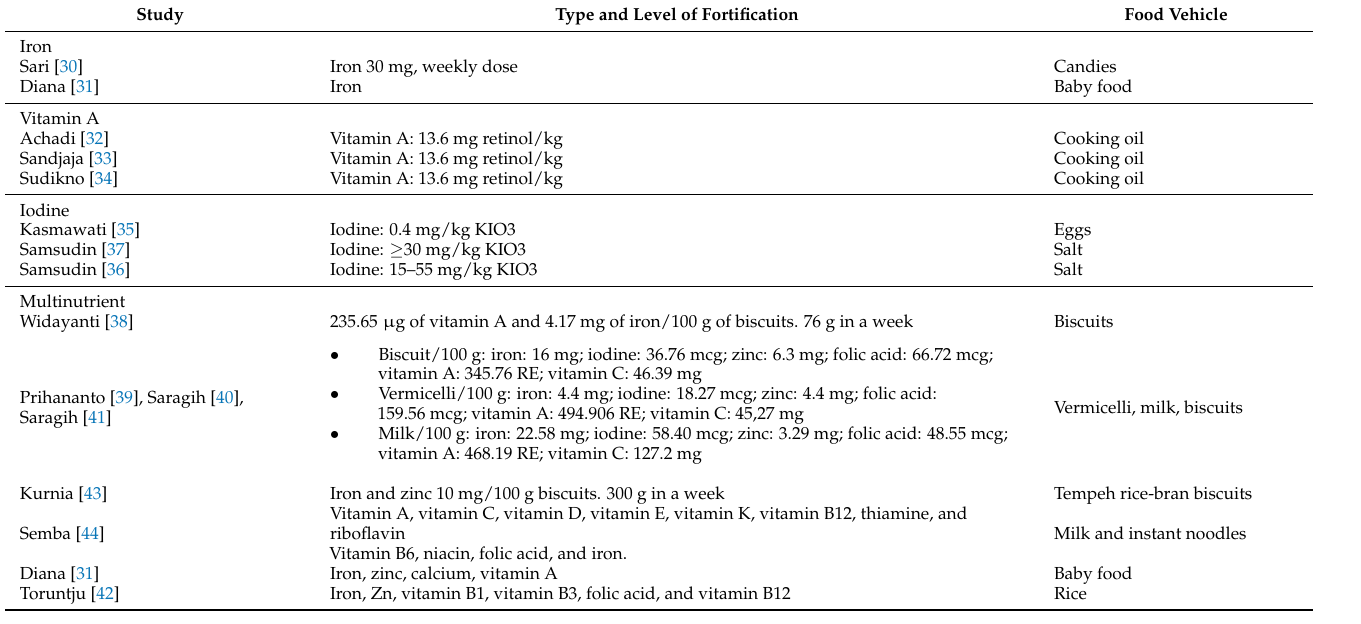
Table 2. Type and level of fortification and food